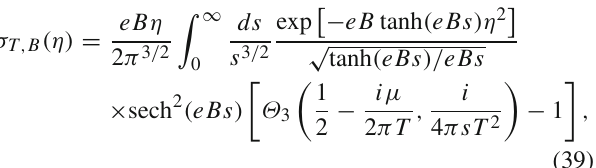
Fig. 5 Behavior of ν(η) as a function of T / √ | eB | = π/ 40. The solid (black) curve corresponds to the 0 . 5 and μ/ numeric expression in Eq. (28). The long-dashed (red) curve corre- sponds to the weak field approximation in Eq. (29). The short-dashed (blue) curve to the strong field expansion in Eq.